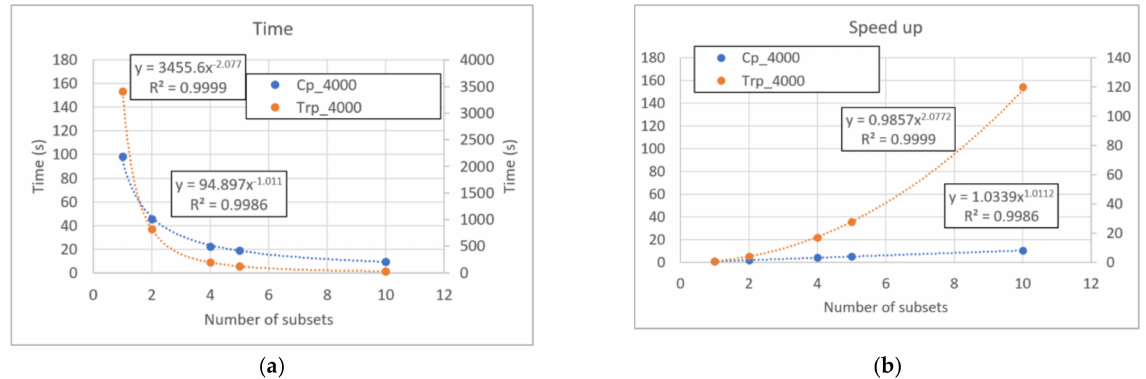
Figure 2. Performance of the piecewise zI algorithm. ( a ) Calculation times (seconds) and ( b ) speeding up the execution of part E of the piecewise zI algorithm on Century systems by using an Intel ® Core™ i7-9750H in the case of evaluation of groups with dimension 2 and 3. In order to have more stable time measurements, each data sample was increased